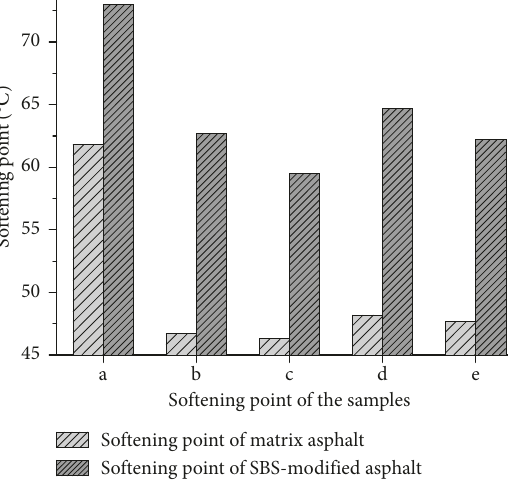
Figure 5: Ductility of the samples.